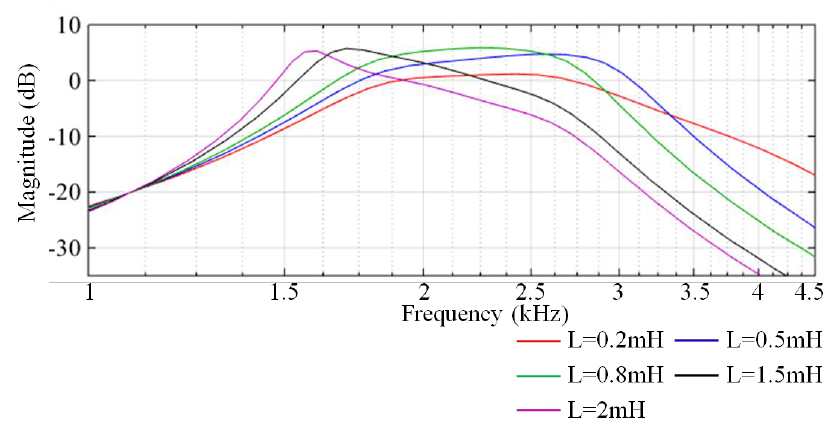
Figure 8. Monte Carlo analysis of the equivalent inductance of the pickup coil.